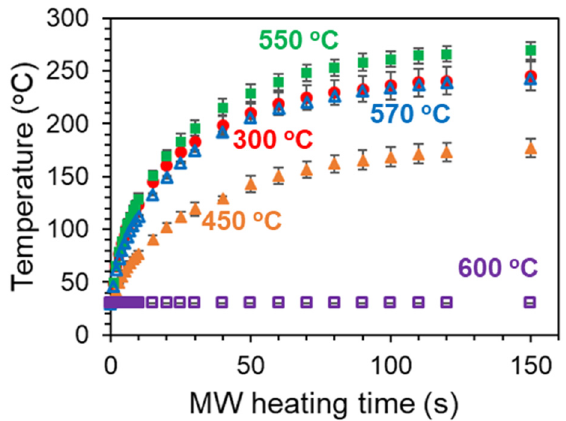
Figure 10. MW heating of 60 s ‐ sputtered Pt/Al 2 O 3 substrates, which were calcined at following temperatures: 300 °C, 450 °C, 550 °C, 570 °C and 600 °C. The substrate samples were put at the maximum point of the electric field. Each heating experiment was repeated 4 times.